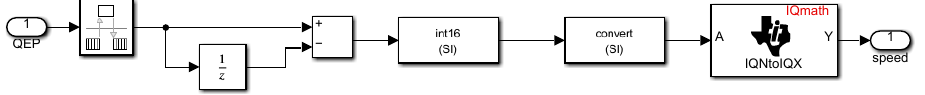
Figure 6. Rotational speed calculation model.